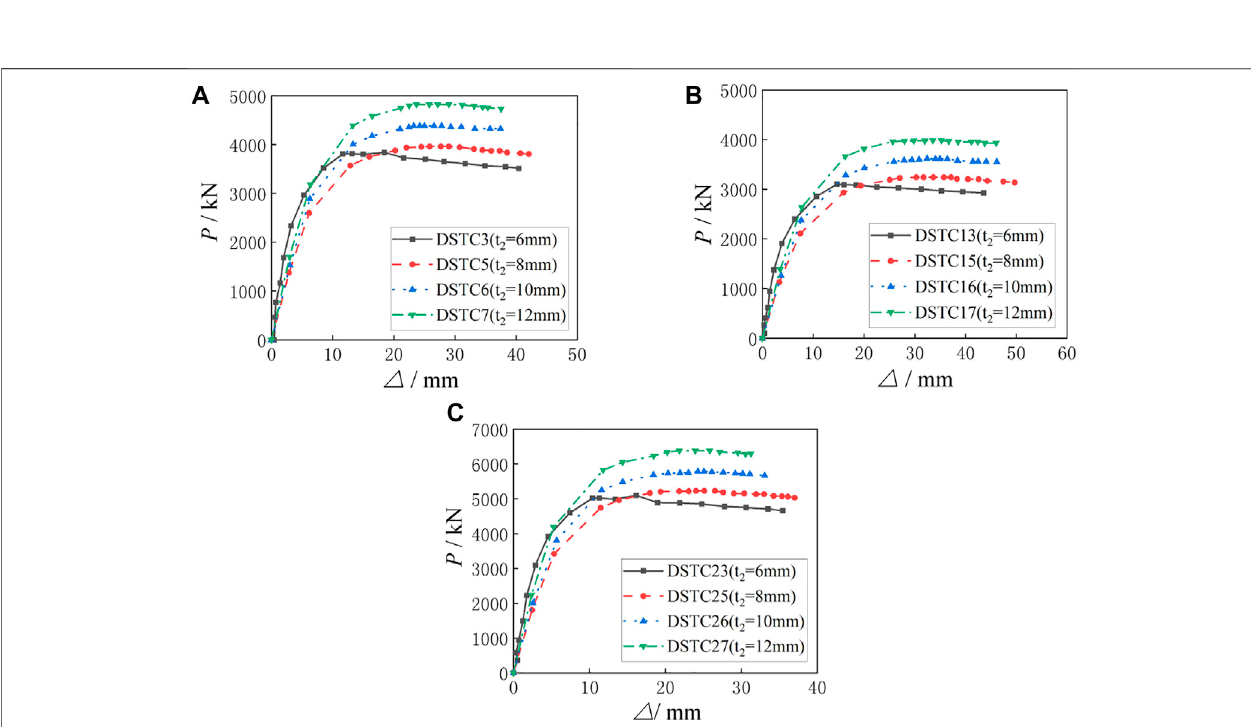
FIGURE 10 | Comparisons of Load-Displacement Curves of Specimens with Different Steel Tube Thicknesses. (A) Load-displacement curves of group A specimens. (B) Load-displacement curves of group B specimens. (C) Load-displacement curves of group C specimens.